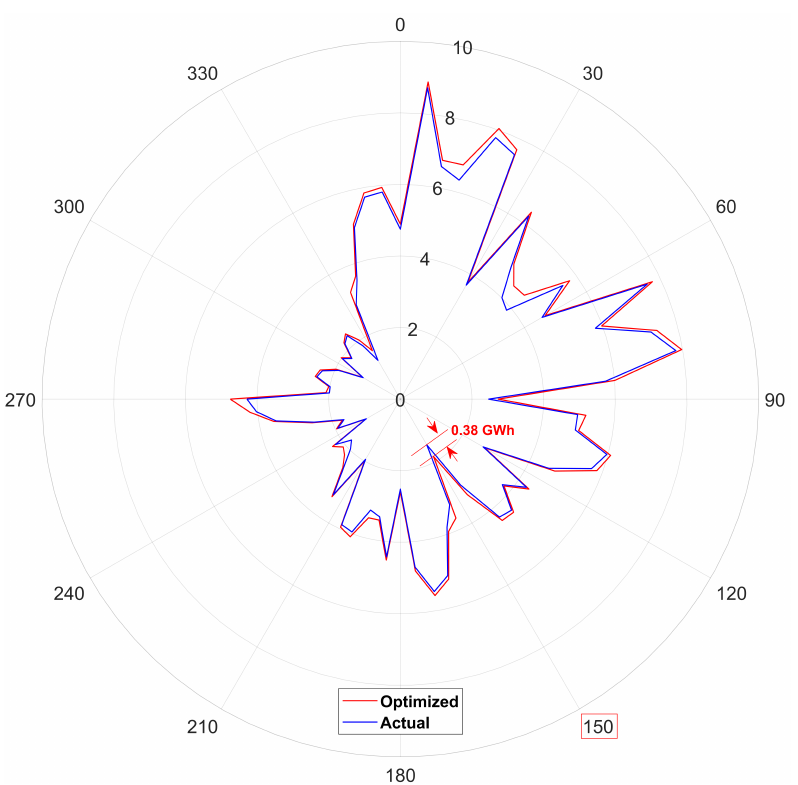
Figure 8. Wind farm’s AEP (GWh) in every wind direction with and without TSR